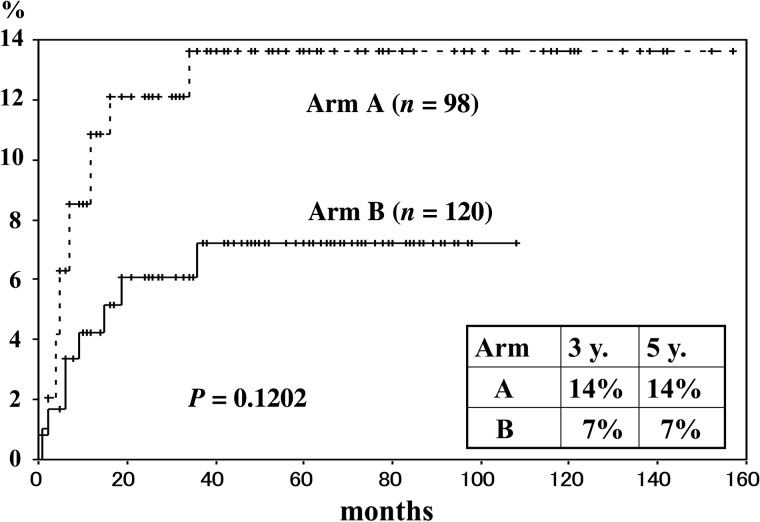
Cumulative local recurrence rate by treatment schedule (June 1998–December 2009).